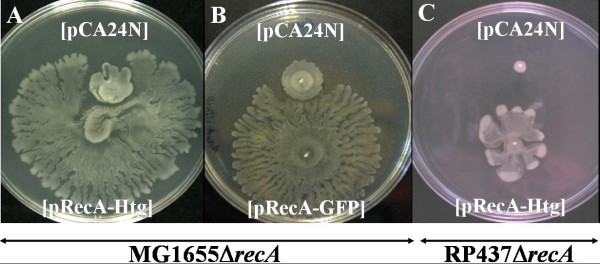
Swarming complementation test. (A) E. coli JMG1655 ΔrecA (pCA24N) and JMG1655 ΔrecA (pRecA-Htg) strains. (B) E. coli JMG1655ΔrecA (pCA24N) and JMG1655ΔrecA (pRecA::GFP) strains. (C) E. coli RP437ΔrecA (pCA24N) and RP437 ΔrecA (pRecA-Htg) strains. Plates were photographed after 24 h of development at 37°C. Plates have a diameter of 9 cm.